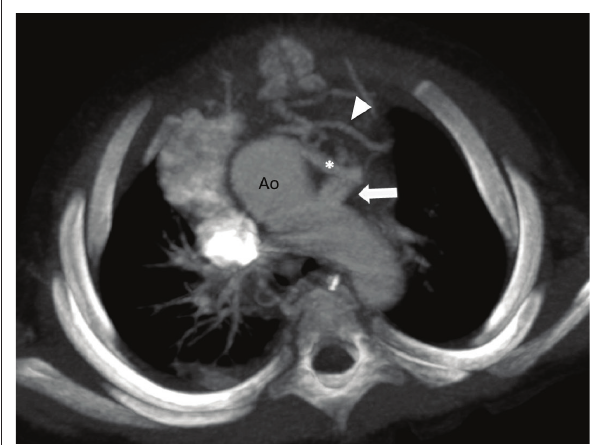
FIGURE 10: Large conus branch (arrowhead) of the RCA in a 6-year-old boy post TOF palliation. Also note central shunt (asterisk) between the anteromedial aspect of the aorta and pulmonary artery stump (arrow).